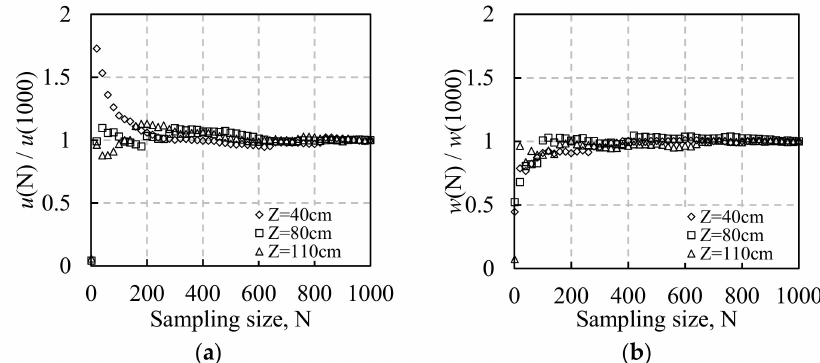
Figure 4. Variation of the RMS velocity with the sampling size when the sampling frequency is 1.5 Hz: ( a ) RMS velocity in the X direction; ( b ) RMS velocity in the Z